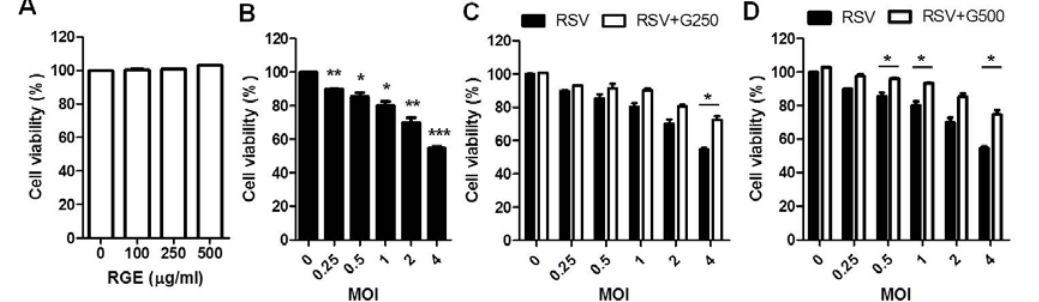
Figure 1. Effects of red ginseng extract (RGE) on respiratory syncytial virus (RSV)-induced cytopathogenic effects. ( A ) Effects of RGE concentrations on the growth of HEp2 cells; ( B ) Effects of different RSV MOIs on the viability of HEp2 cells. * p < 0.05; ** p < 0.01; *** p < 0.001 vs. non-infected cells; ( C , D ) Effects of different RGE concentrations on the viability of HEp2 cells infected with RSV at different MOIs 48 h post infection. HEp2 cells were continuously treated with RGE starting 24 h prior to infection and during the infection period. Values are the mean ± SEM. * p < 0.05. G250: 250 μg RGE per mL, G500: 500 μg RGE per mL.